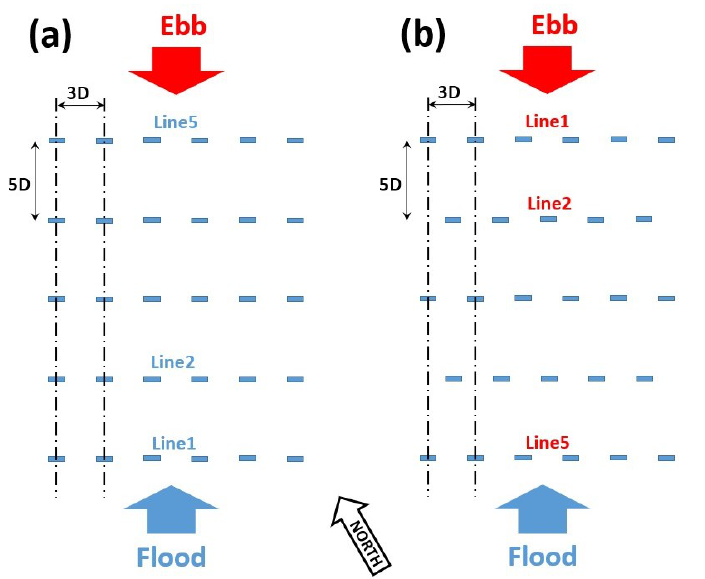
Figure 3. Schematic representation of the two configurations. ( a ) Aligned layout and ( b ) staggered layout. The rows are numbered in the direction of the flow. Thus, line 1 stands for the row located in the free